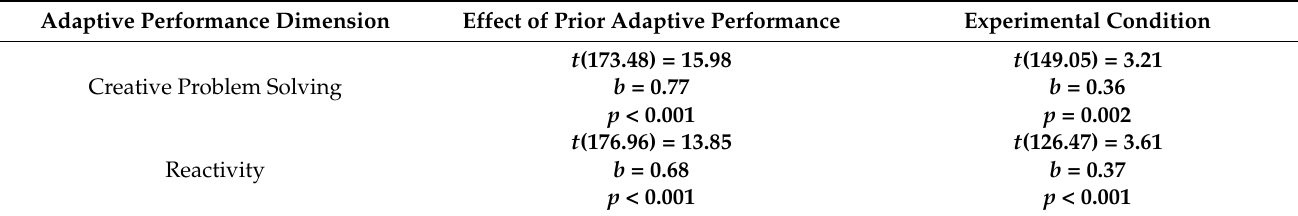
Table 4. Outputs of models predicting post-condition adaptive performance sub-scores based on prior adaptive performance and experimental